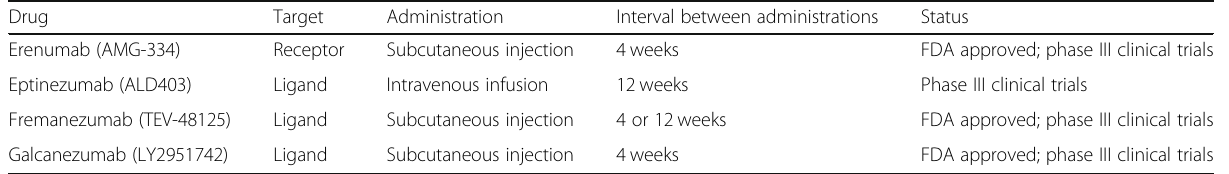
Table 3 Overview of anti-calcitonin-gene related (CGRP) (receptor) peptide monoclonal antibodies in order by target and alphabetical